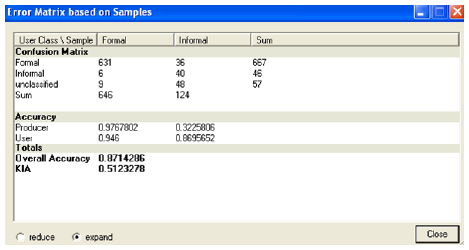
Figure 9. Accuracy